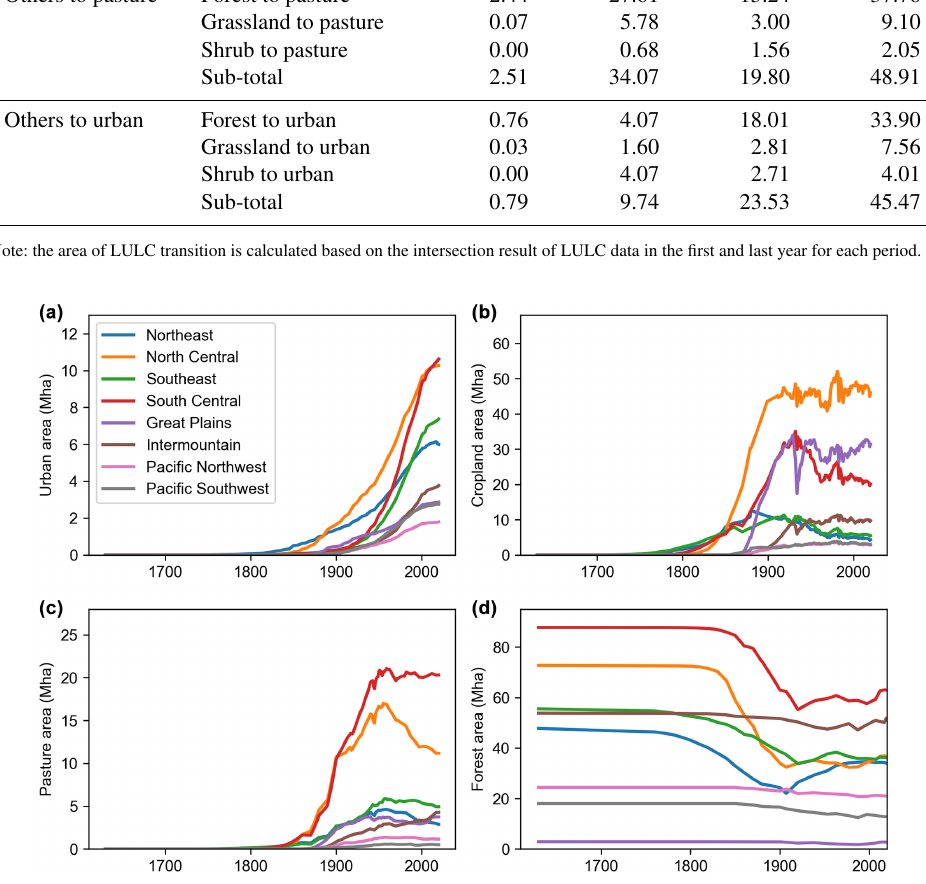
Figure 8. Changes in areas of urban land (a) , cropland (b) , pasture (c) , and forest (d) in different geographic regions during